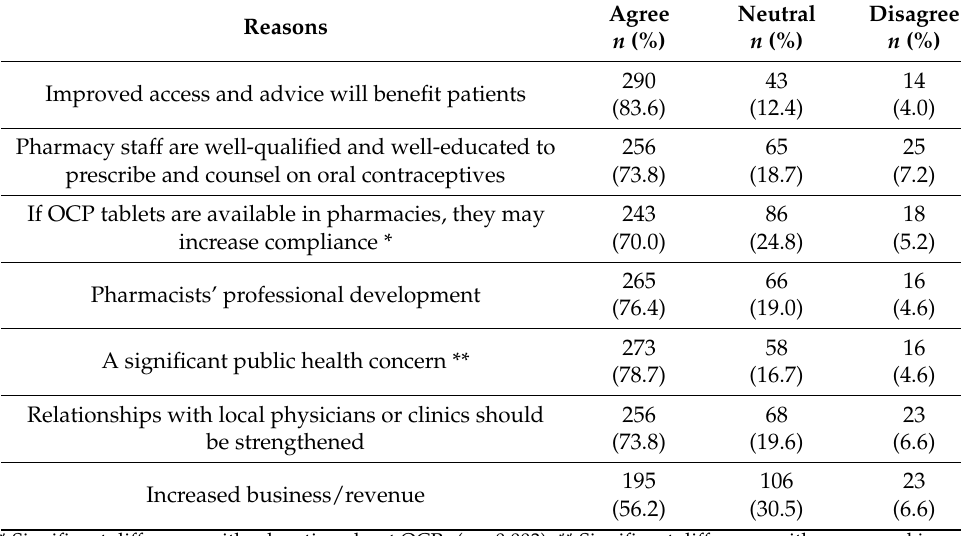
Table 5. Reasons for the community pharmacists’ willingness to prescribe oral contraceptives.